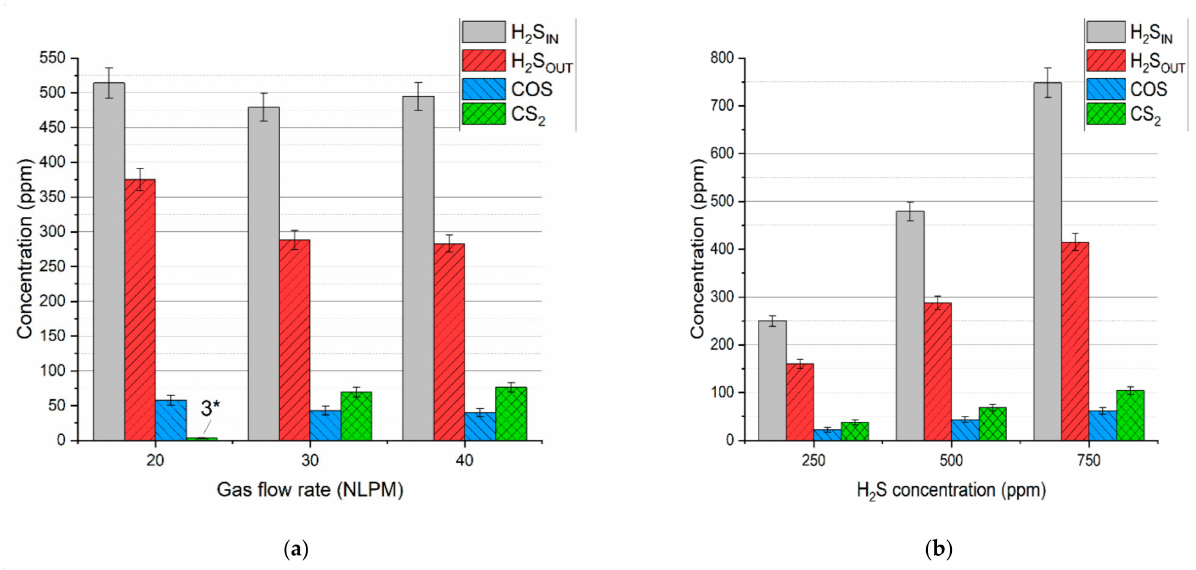
Figure 6. Concentration of the gaseous sulfur compounds depending on: ( a ) gas flow rate and ( b ) initial hydrogen sulfide concentration. *—concentration below the calibration range.